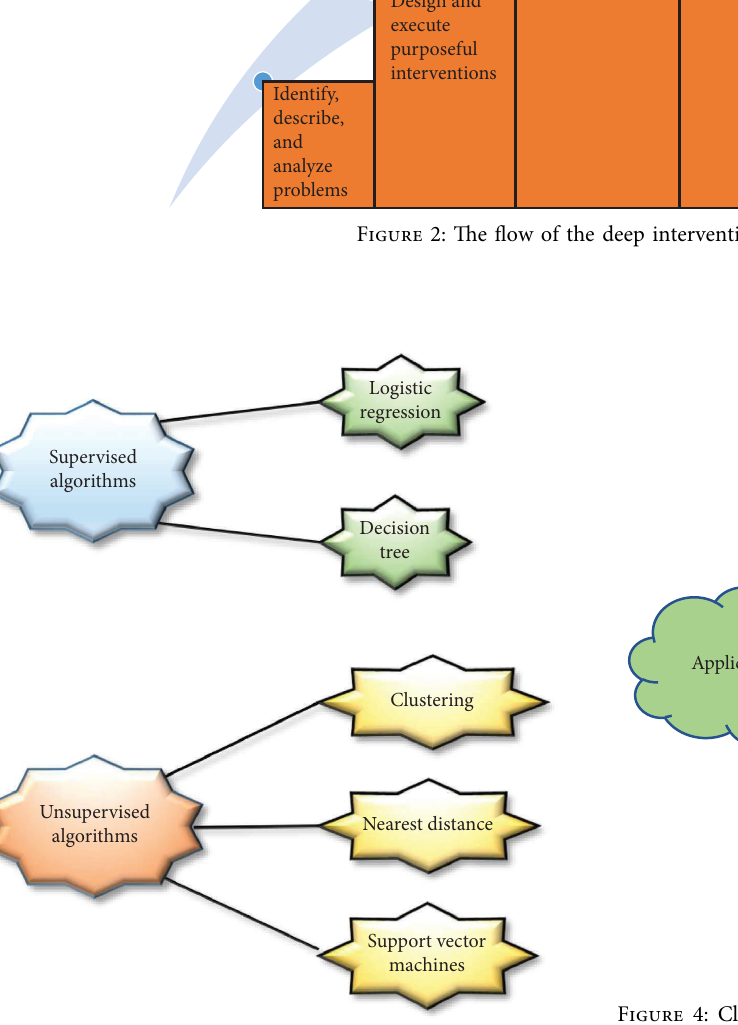
Figure 3: Classifcation of data mining techniques from a theo- retical perspective.